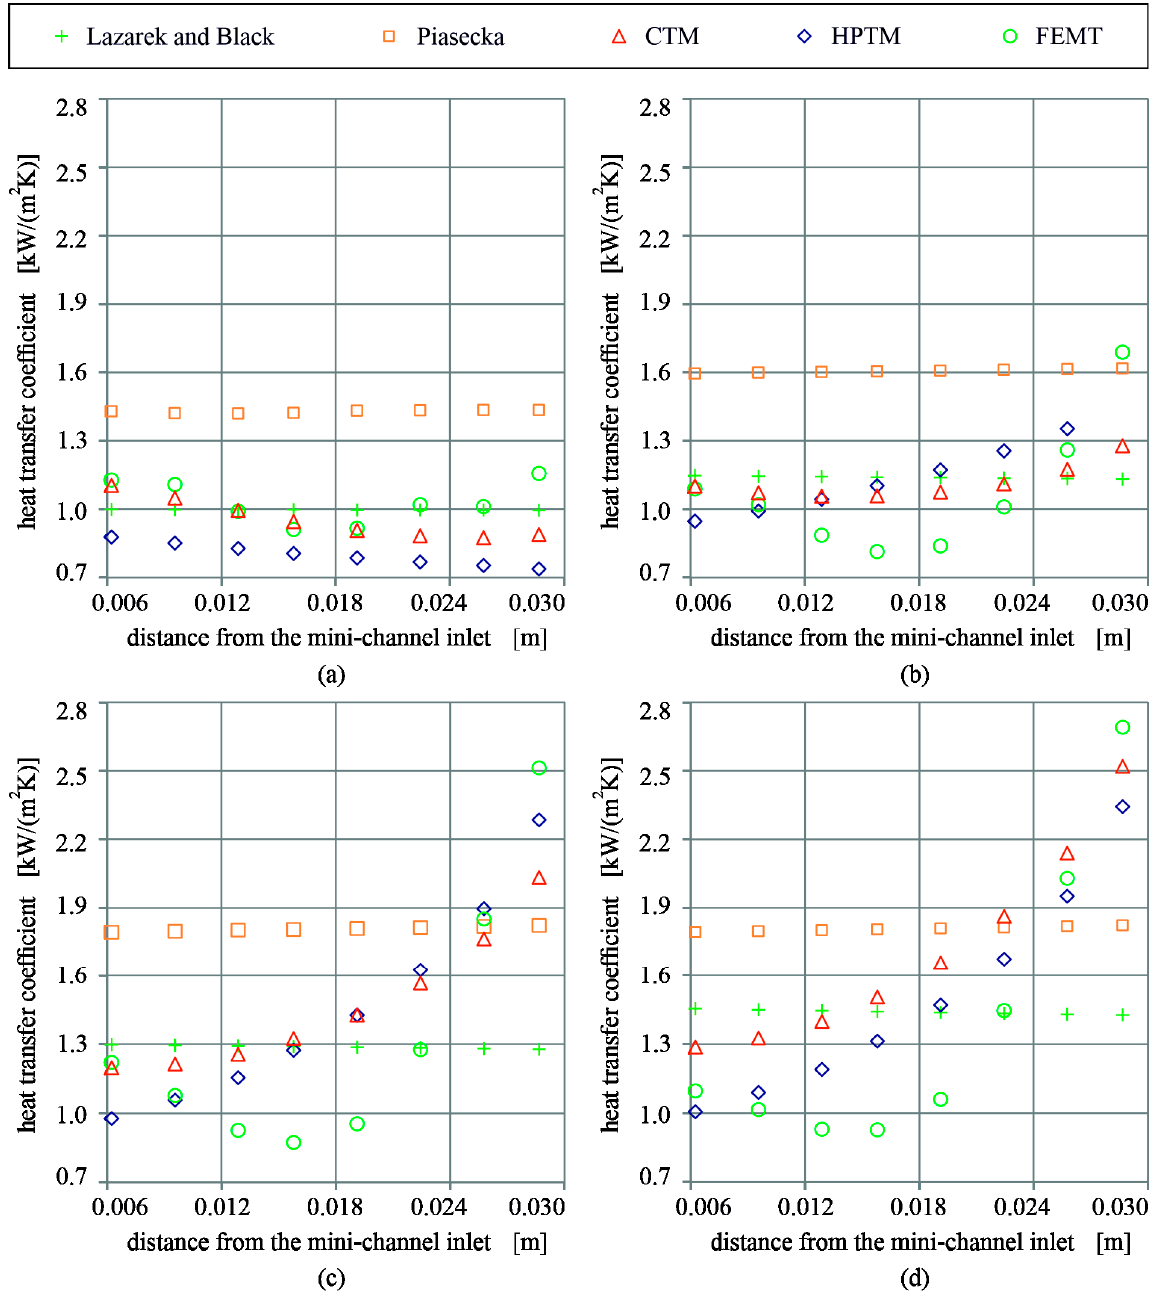
Figure 17. Heat transfer coefficient versus the distance from the mini-channel inlet, calculated according to proposed mathematical methods and theoretical correlations from the literature, based on the data collected at the following time moments of the experimental set: ( a ) 340 s, ( b ) 380 s, ( c ) 420 s, and ( d ) 460 s; experimental parameters are listed in Table 1.